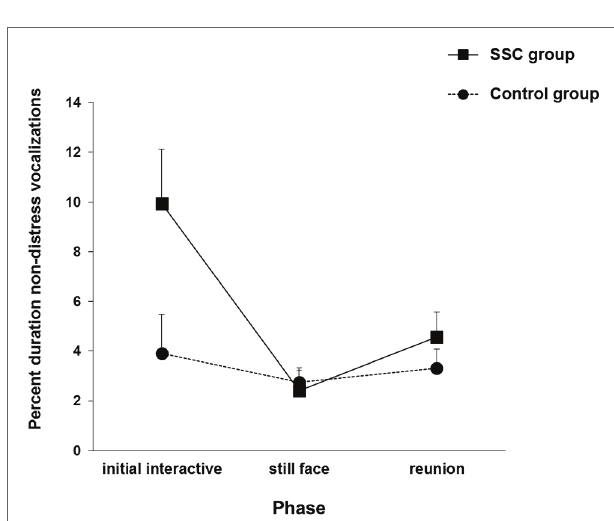
FIGURE 2 | Infants’ non-distress vocalizations in the SSC and control groups during each phase of the Still Face Task at the 1-month visit. Vertical bars represent standard errors. Adapted from Bigelow and Power (2012, p. 245). Copyright © 2012, with permission from Elsevier.